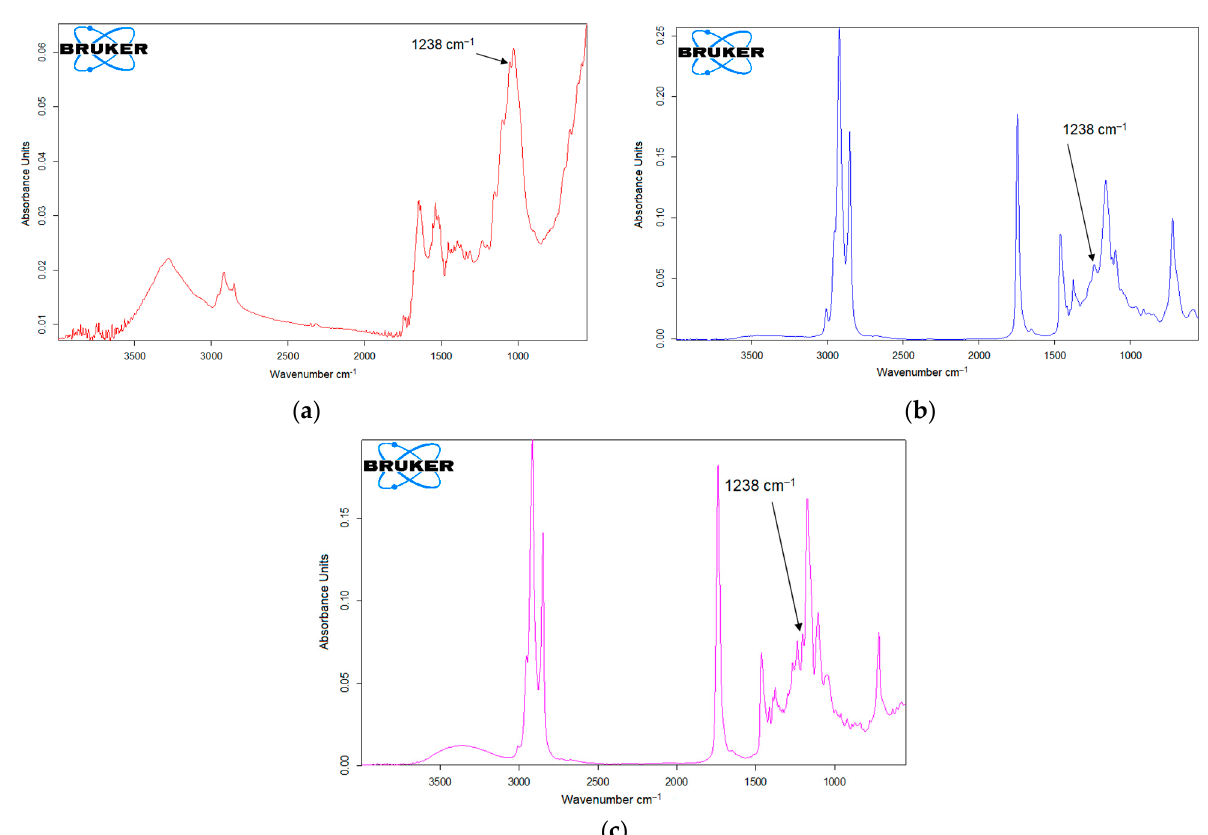
Figure 13. FTIR analysis of the products Spirulin ( a ), Ghindazin ( b ), and Tuiazin ( c ).